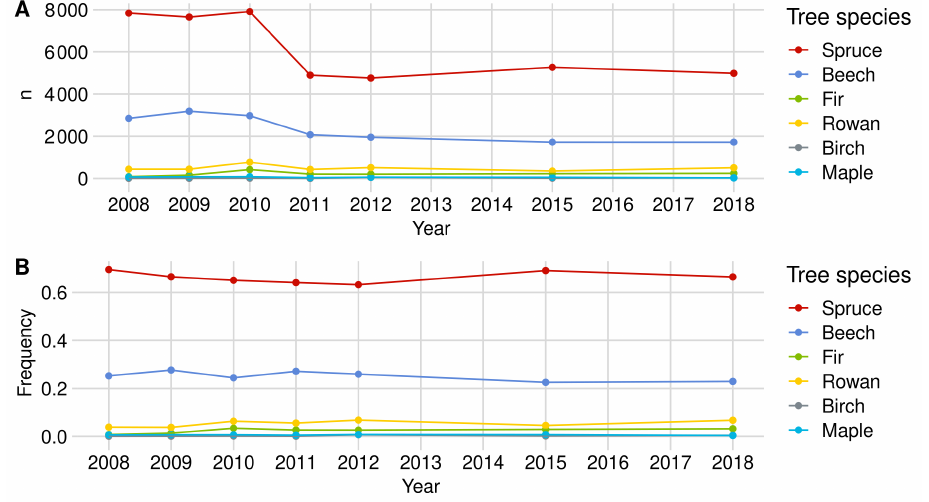
Figure A2. Sample size development of the main tree species over time in the FRG in ( A ) total numbers (n) and ( B ) relative